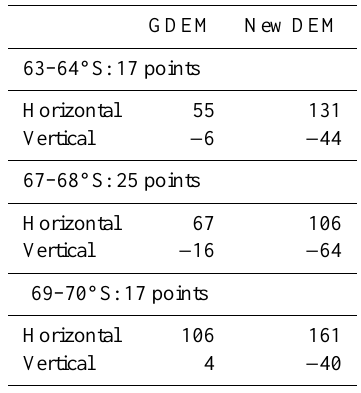
Table 4b. Consistency tests, based on points obtained from SPIRIT DEMs in north, mid- and south Antarctic Peninsula regions (see Fig. 10). Values are mean di ff erences in